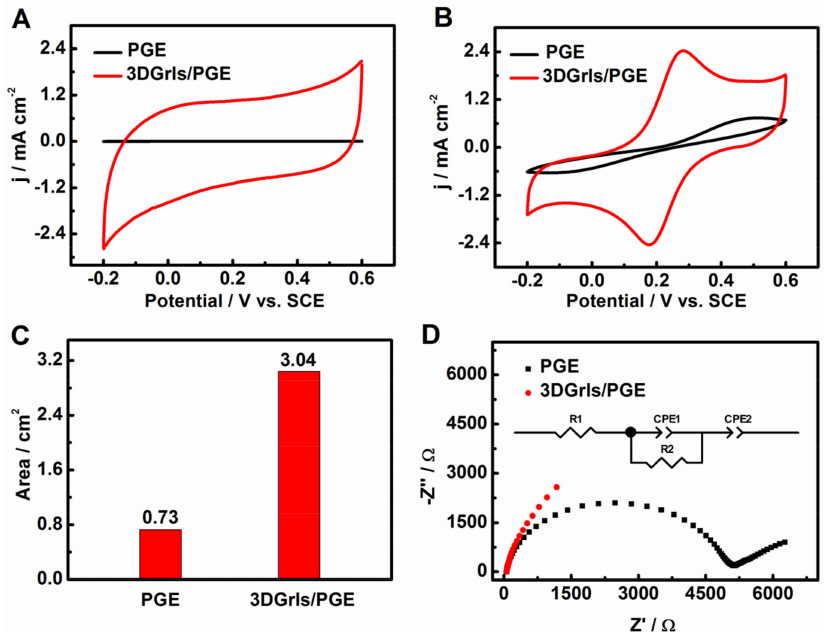
Figure 3. The CV curves of PGE and 3DGrls/PGE in ( A ) pH 9.18 PBS and ( B ) 0.1-M KCl solution containing 5-mM [Fe(CN) 6 ] 3 − /4 − at a scan rate of 50 mV s − 1 . ( C ) The corresponding area histogram of PGE and 3DGrls/PGE. ( D ) The EIS of PGE and 3DGrls/PGE with the voltage amplitude at 50 mV in the frequency range 10 − 2 –10 5 Hz. The inset shows the respective equivalent circuit diagram, where R 1 , R 2 and CPE represent the solution resistance, charge transfer resistance and constant phase elements, respectively.